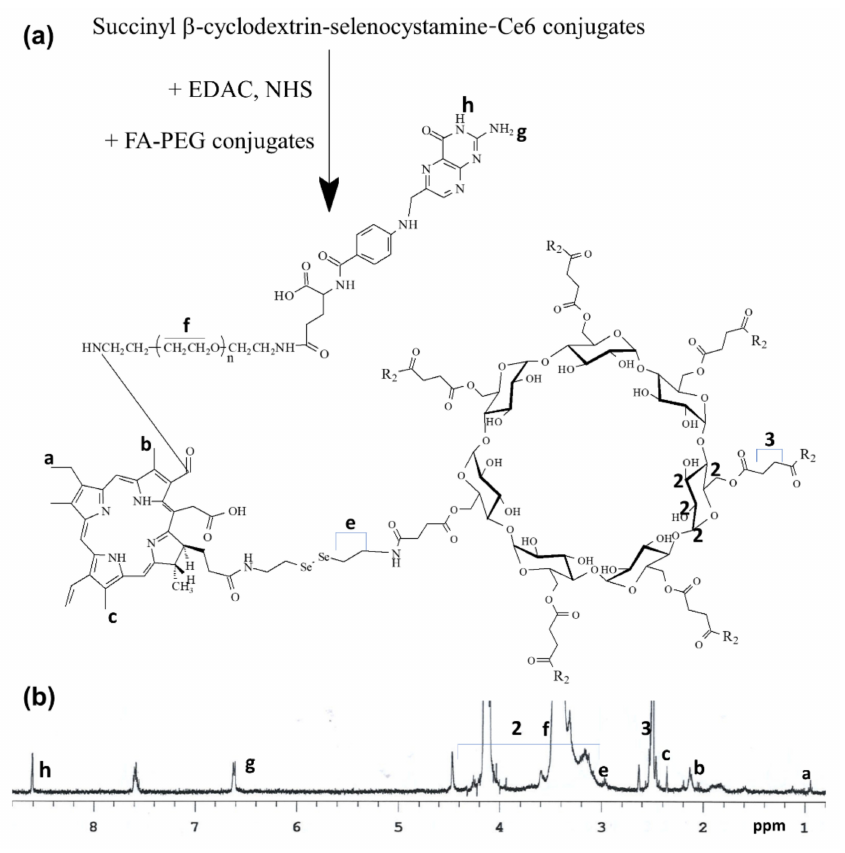
Figure 2. Synthesis scheme ( a ) and 1 H NMR spectra ( b ) of FaPEGbCDseseCe6